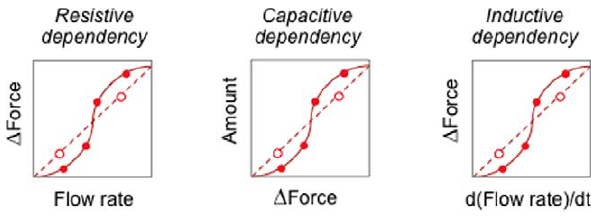
Figure 5. Examples of linear and non-linear dependencies. OPB:C onstitutive physical dependency subclasses are quantitative relationships between pairs of dynamical properties. One or more parameters are required for mathematical functions being used to compute the shape of the